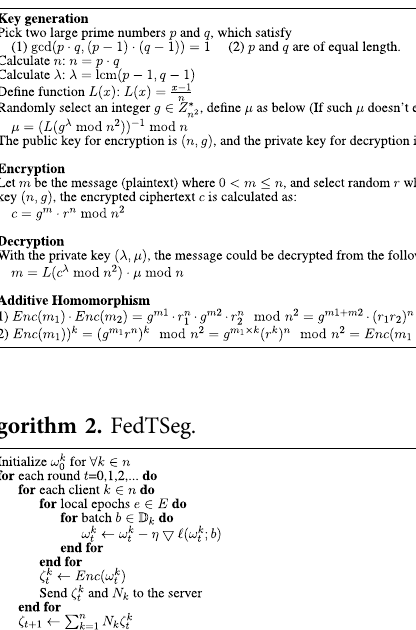
Algorithm 1. Paillier cryptosystem.